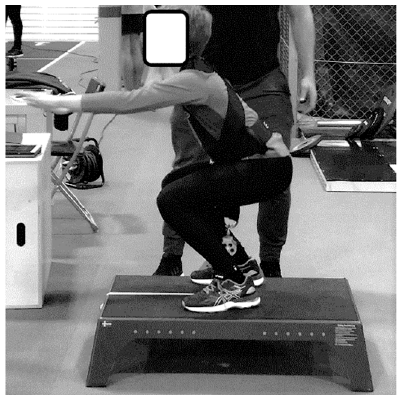
Figure 2. A squat performed on the flywheel device.